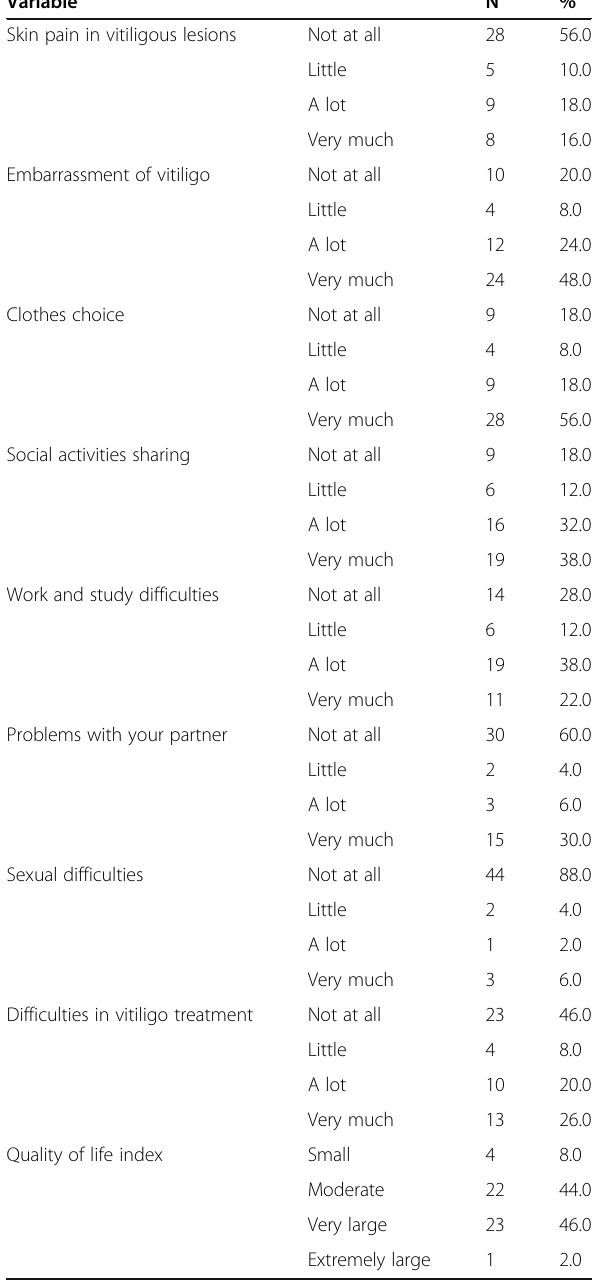
Table 3 Quality of life index in vitiligo patients Variable N Skin pain in vitiligous lesions